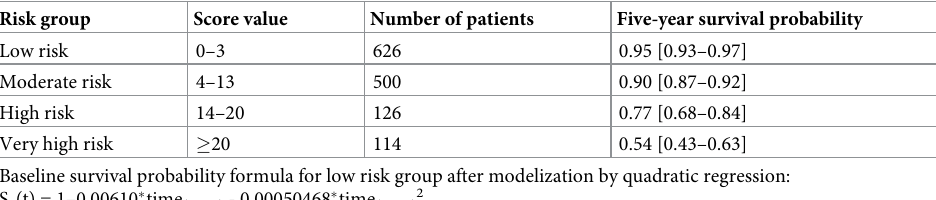
Table 4. Five-year Kaplan-Meier survival probabilities in each score